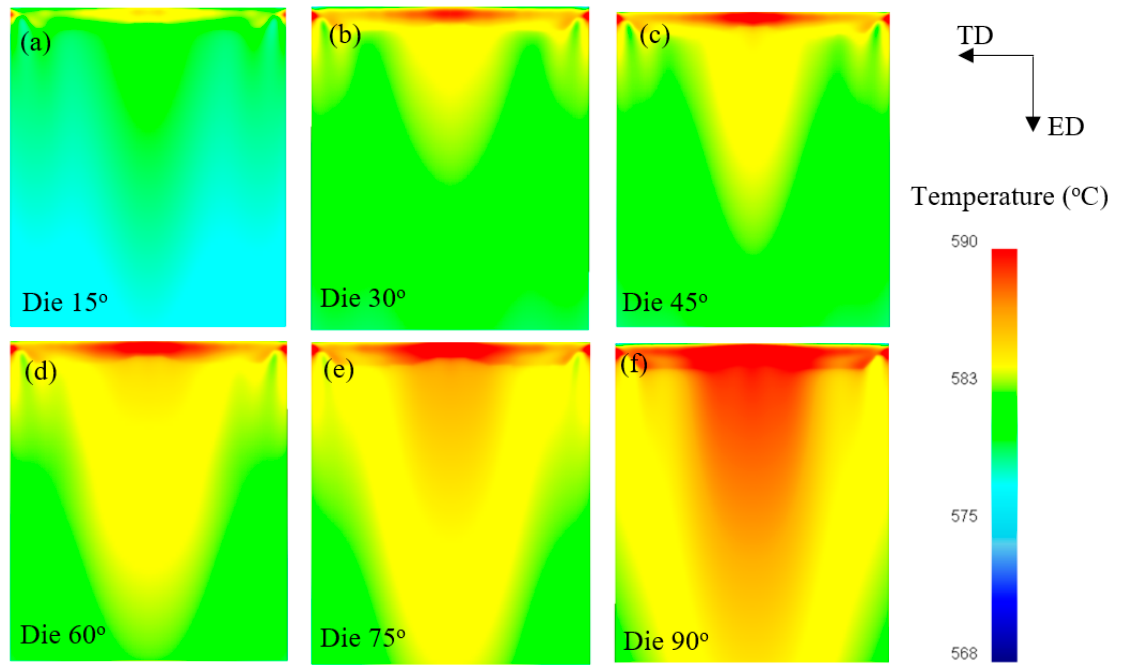
Figure 9. Model-predicted surface temperature distribution of the extrudate’s surface just after the die exit of porthole extrusions made using varying lower bridge angles: ( a ) die 15°, ( b ) die 30°, ( c ) die 45°, ( d ) die 60°. ( e ) die 75° and ( f ) die 90°.